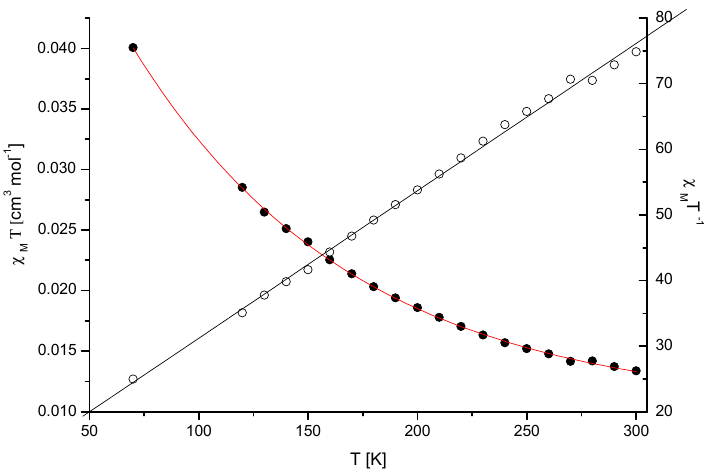
Figure 1. Plot of χ M T vs. T for the crystalline sample of Mn-dipyCO-NO 3 . The solid lines were theoretical ones.